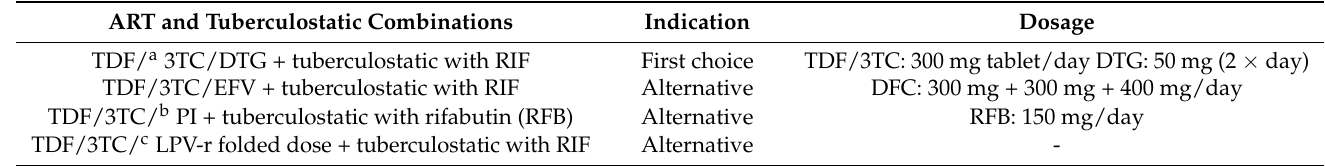
Table 1. Recommendations for the simultaneous use of ARV and tuberculostatics